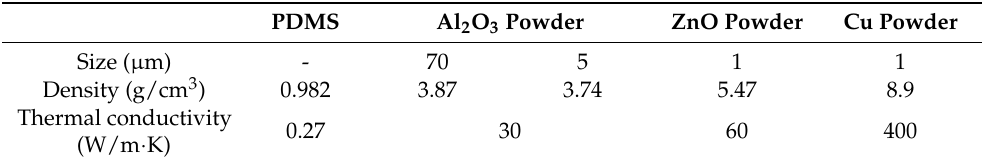
Table 1. Properties of PDMS [32] , aluminum oxide [23,33], zinc oxide [23,34], and copper [35] powder.